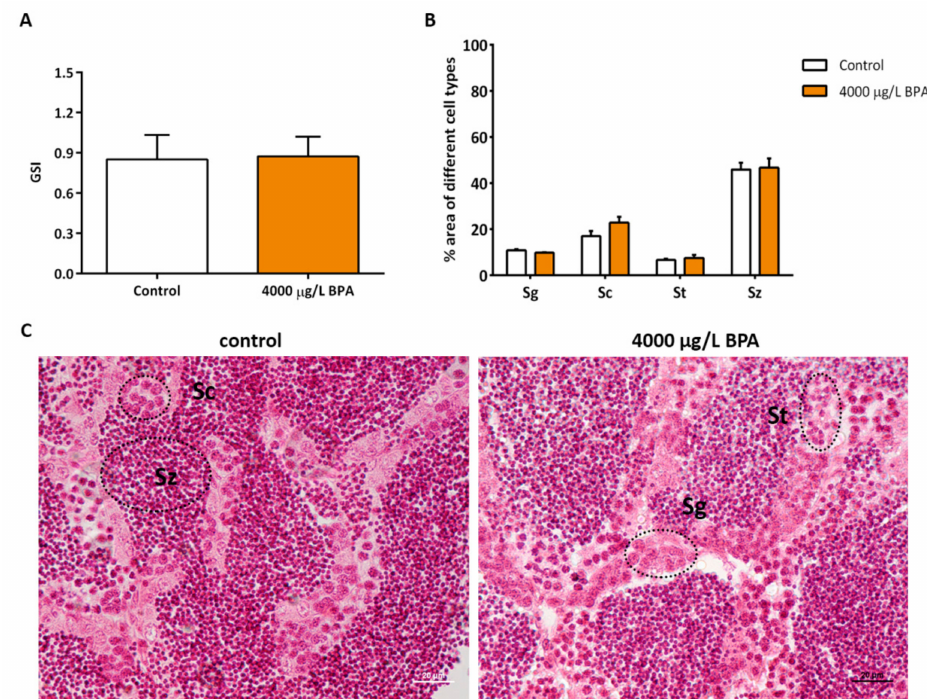
Figure 3. Evaluation of testicular status in adult males. ( A ) GSI (gonado-somatic index) of testicles from 5 control and 5 BPA-exposed fish in each of the 3 di ff erent replicates ( n = 3). ( B ) morphometric study showing the percentage of each cell type: sg (spermatogonia), sc (spermatocyte), st (spermatid), and sz (spermatozoa) of both testicles from 3 di ff erent males per treatment ( n = 3). ( C ) representative images of testicular cell types in control and treated fish. 4 µ m-slices were stained with hematoxylin-eosin; scale bar 20 µ